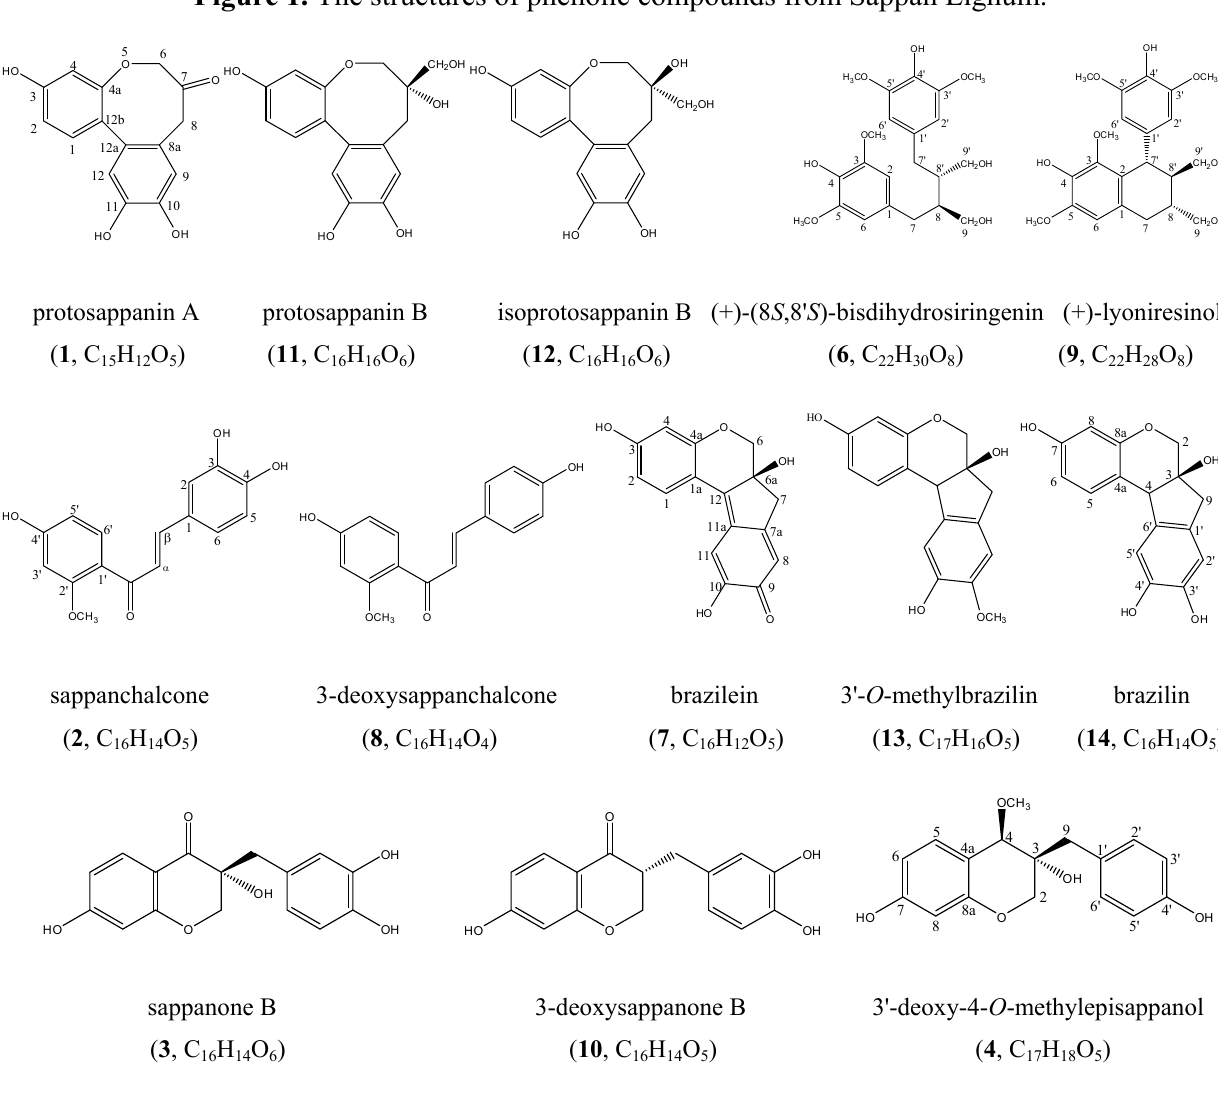
Figure 1. The structures of phenolic compounds from Sappan